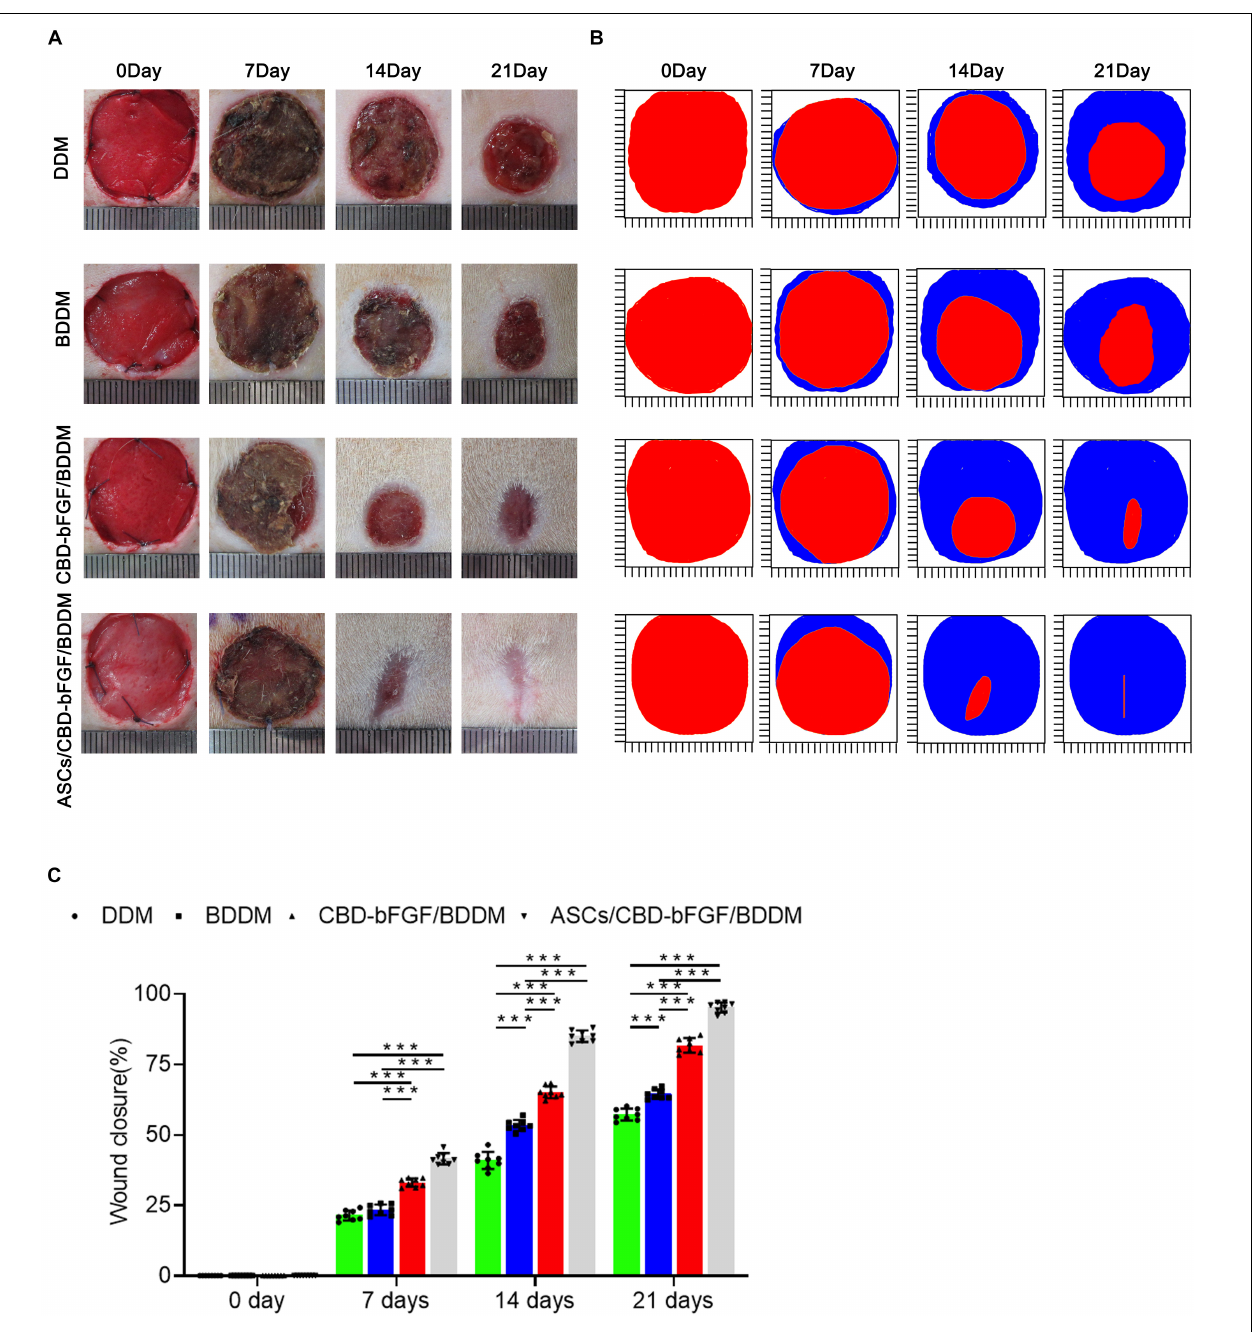
FIGURE 7 | (A) Overview of the size change of the wounds made in the dorsal skin of diabetic mice among the four groups at postoperative days 0, 7, 14, and 21. (B) Traces of wound bed closure for each treatment group in vivo . The red area indicates the wound area at day 0, and the blue area indicates the wound area at postoperative days 7, 14, and 21. (C) Statistical analysis of the wound area in each group at postoperative days 0, 7, 14, and 21. Data are shown as means ± standard deviation (* P < 0.05, ** P < 0.01, and *** P <